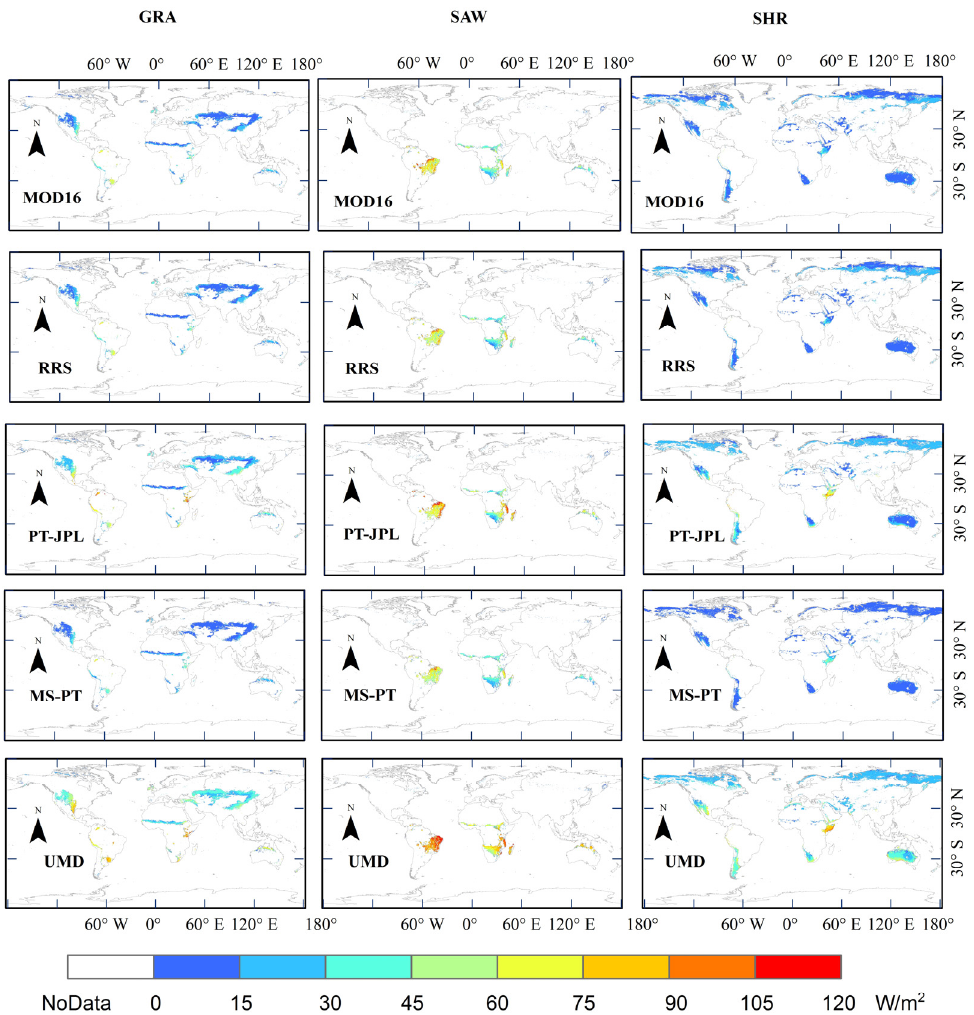
Figure 8. Estimated annual global terrestrial LE for grassland, savanna and shrubland averaged for 2003–2006 at spatial resolution of 0.05° from algorithms driven by GMAO-GERRA